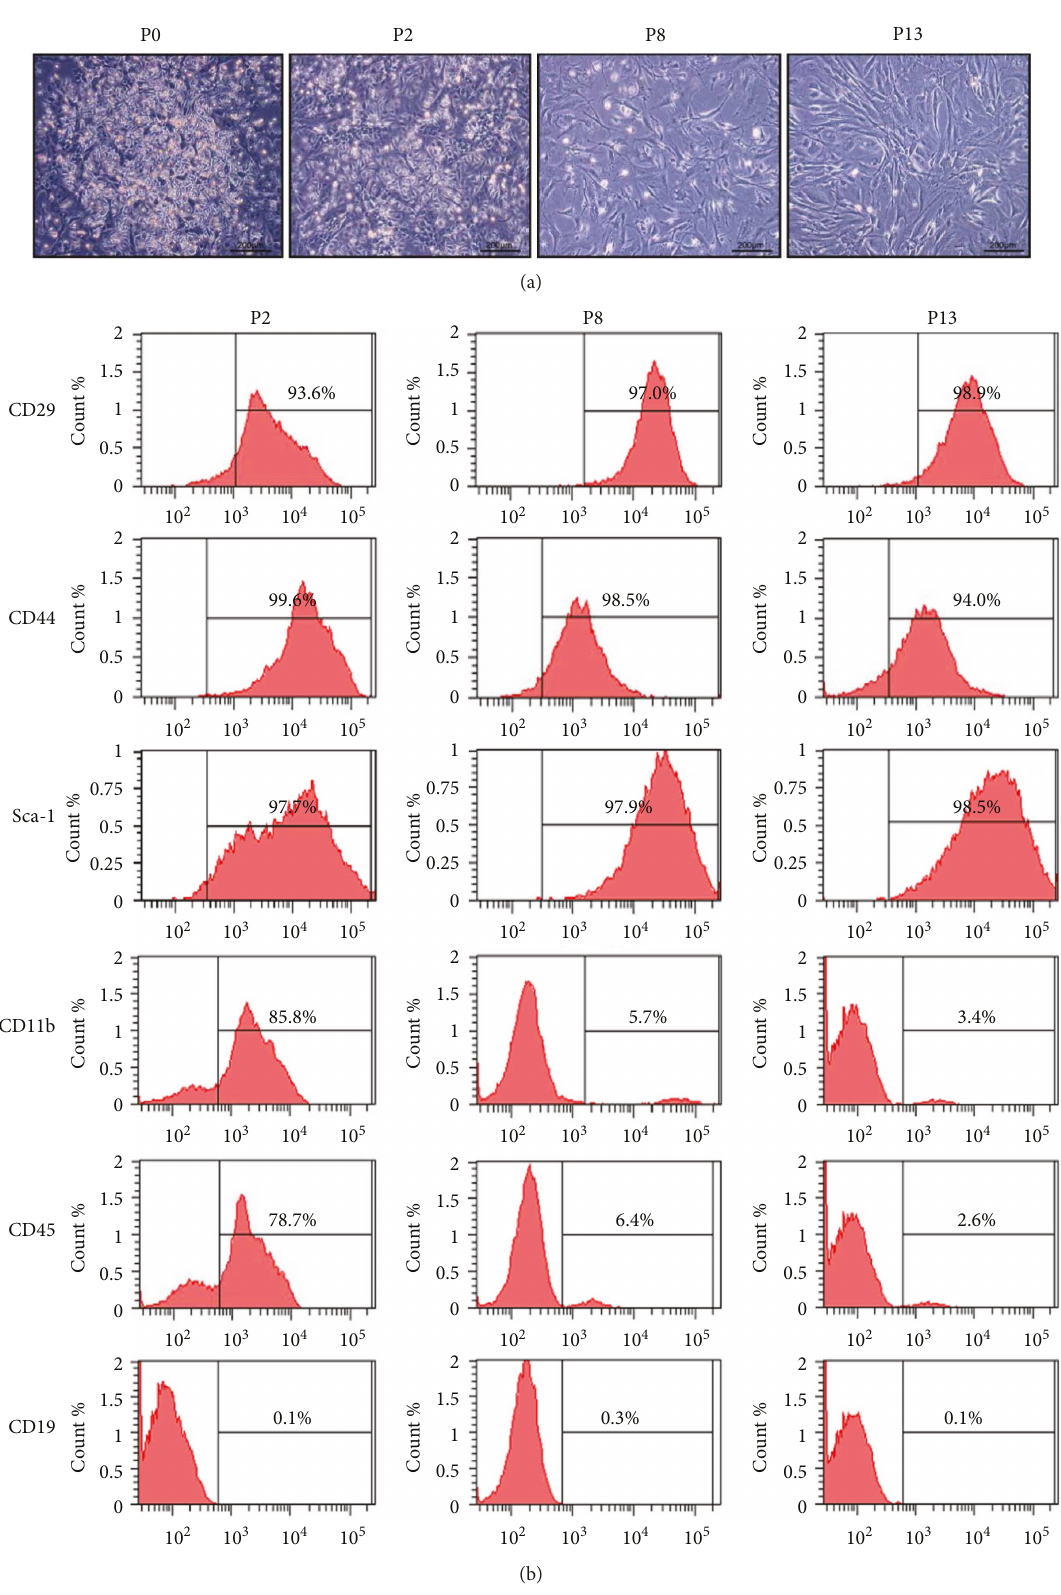
Figure 5: Morphology and cell surface markers of BM-MSCs at di ff erent passages cultured in 5% oxygen condition. (a) Phase contrast images of BM-MSCs at P0, P2, P8, or P13 ( × 100 with scale bar = 200 μ m). (b) The expression of CD29, CD44, Sca-1, CD11b, CD45, and CD19 surface markers of BM-MSCs at P2, P8, or P13 determined by fl ow